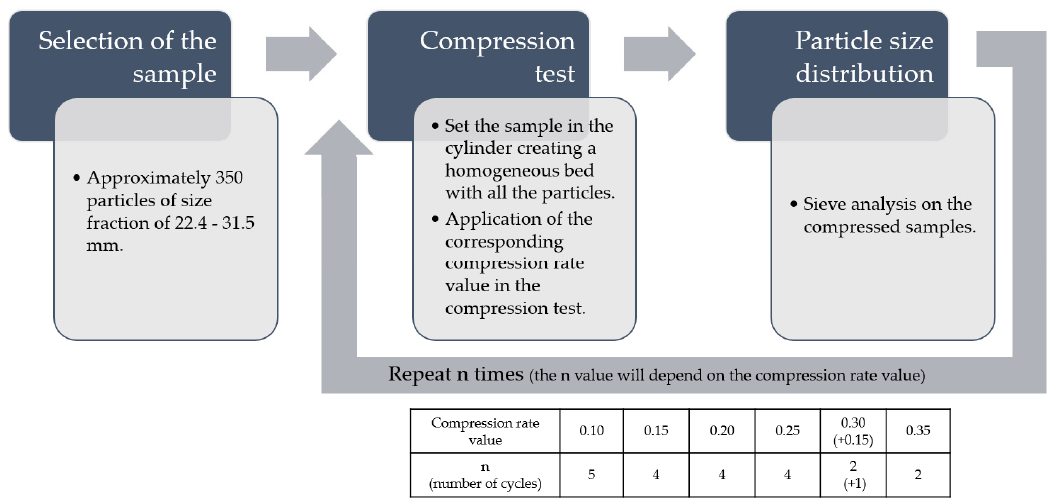
Figure 3. General test procedure for interparticle Breakage (IPB).